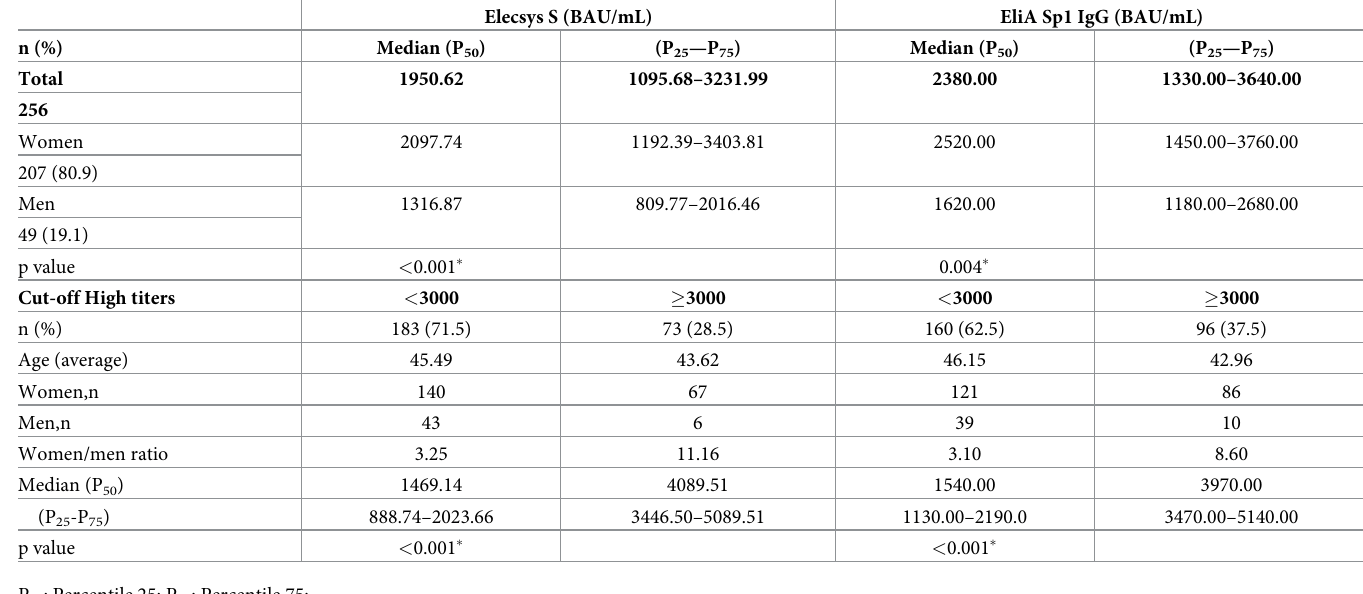
Table 2. Descriptive analysis of antibodies concentrations by Elecsys Anti-SARS-CoV-2 S and EliA SARS-CoV-2-Sp1 IgG in the 256 non-infected volunteers included in the